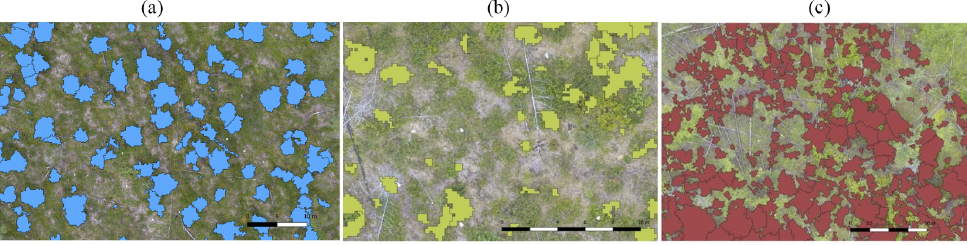
Figure 14. (a) Crown polygons for plot EN18014 with Q1 quality score. (b) Crown polygons for plot EN18014 with Q2 quality score. (c) Crown polygons for plot EN18014 with Q3 quality score. The scale bar represents